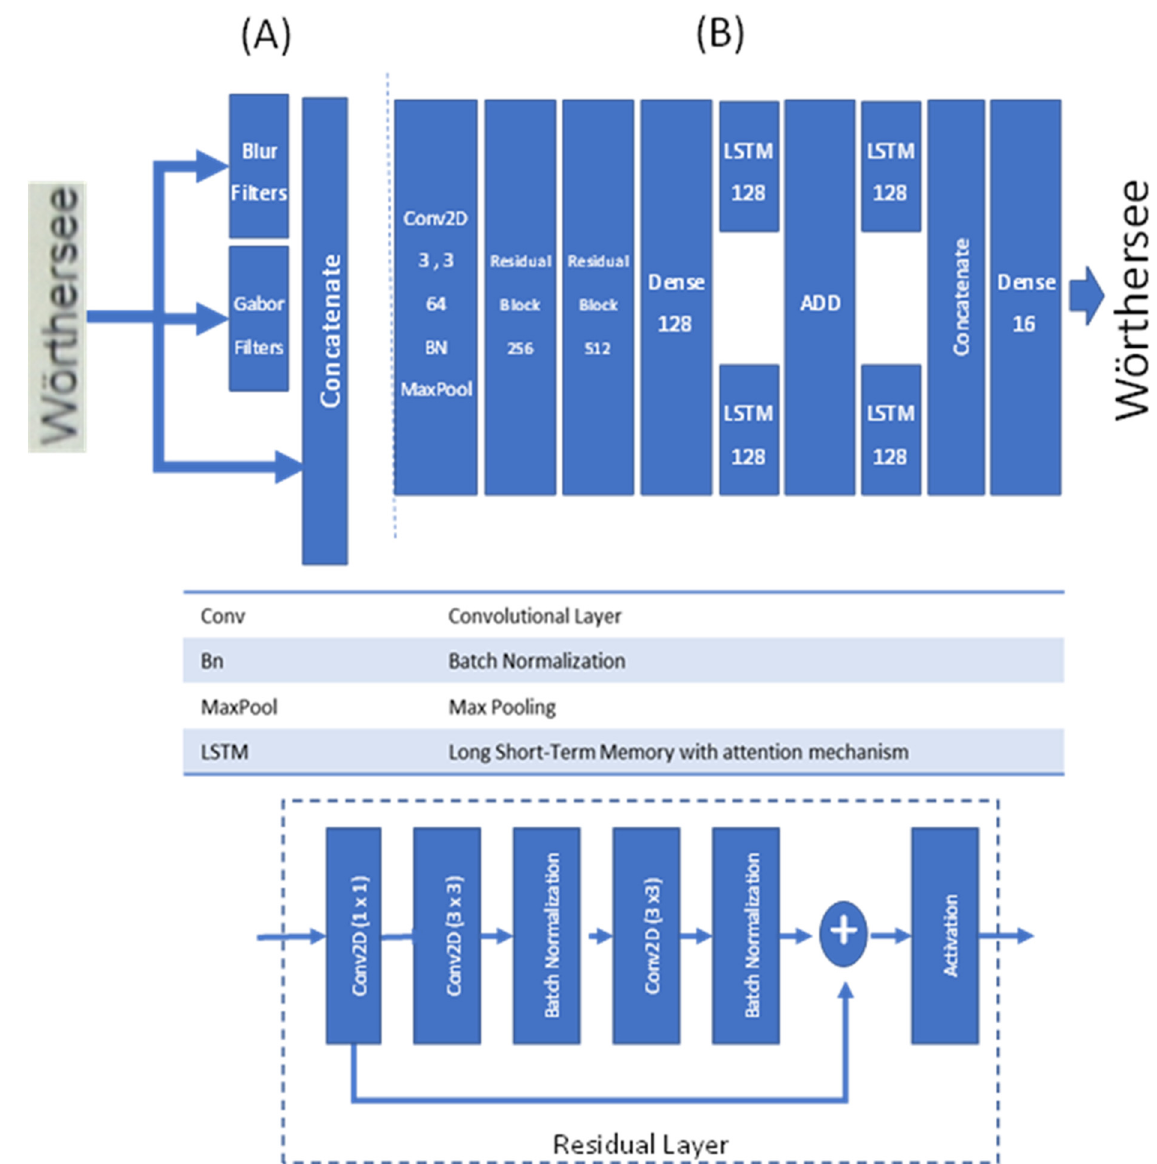
Figure 11. Our new text recognition architecture for Module 2 (of the architecture shown in Figure 4): This module starts with ( A ) preprocessing layers, and continues with ( B ) feature extraction of the text image. In the middle, the model uses residual layers and LSTM with an attention mechanism to perform feature fusion. Finally, the model uses those features to find/determine a word.